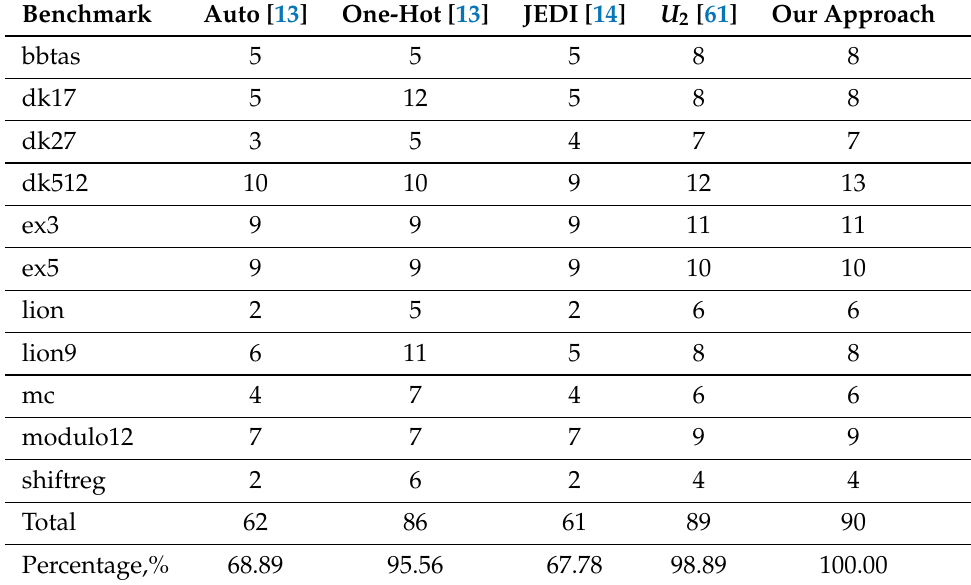
Table 9. Experimental results (LUT counts for benchmarks of G0).